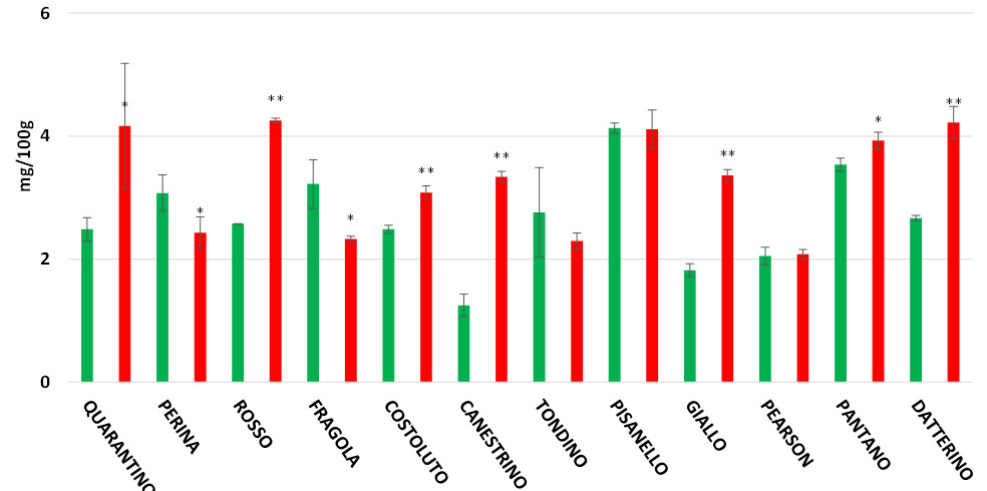
Figure 8. Total flavonoids content (expressed as mg/100 g of FW) in tomato pulp of 9 Italian cultivars and three commercial cultivars. Controls (CTRL) in green and drought-stressed group (DS) in red. The bars indicate the standard deviation. A significantly difference is shown between CTRL and DS of each cultivar by * for a p ≤ 0.05 and ** for p ≤ 0.01.